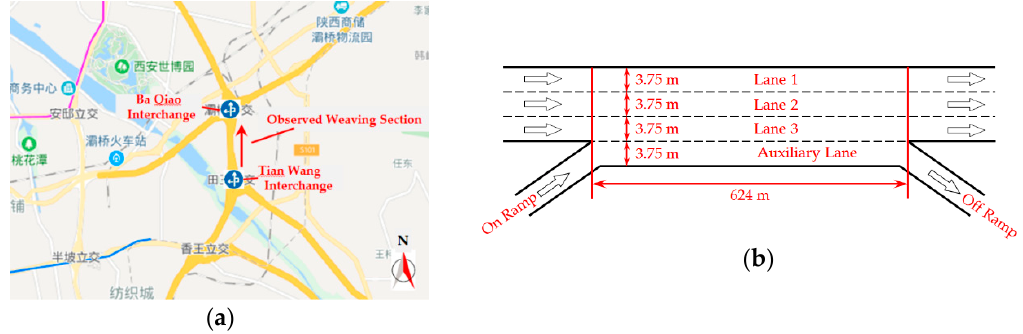
Figure 2. The observed weaving section. ( a ) Location of the observed weaving section; ( b ) Configuration of the observed weaving section